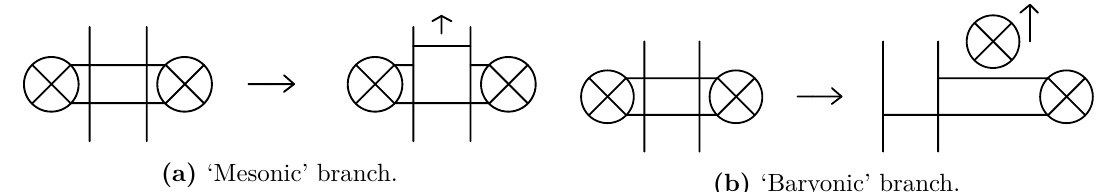
Figure 13. SU(2) with two flavors.